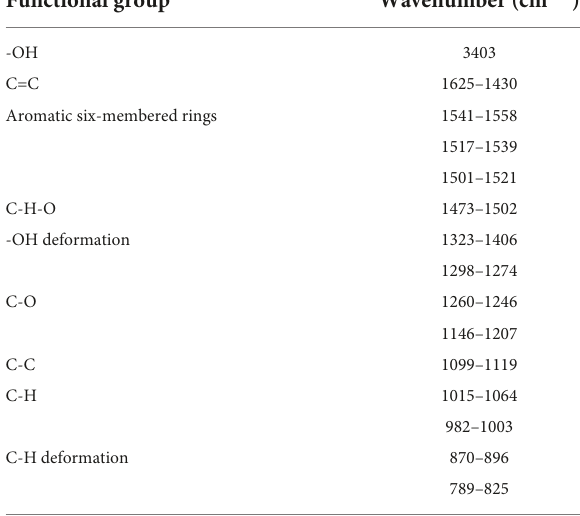
TABLE 2 Functional groups of chemical compounds in